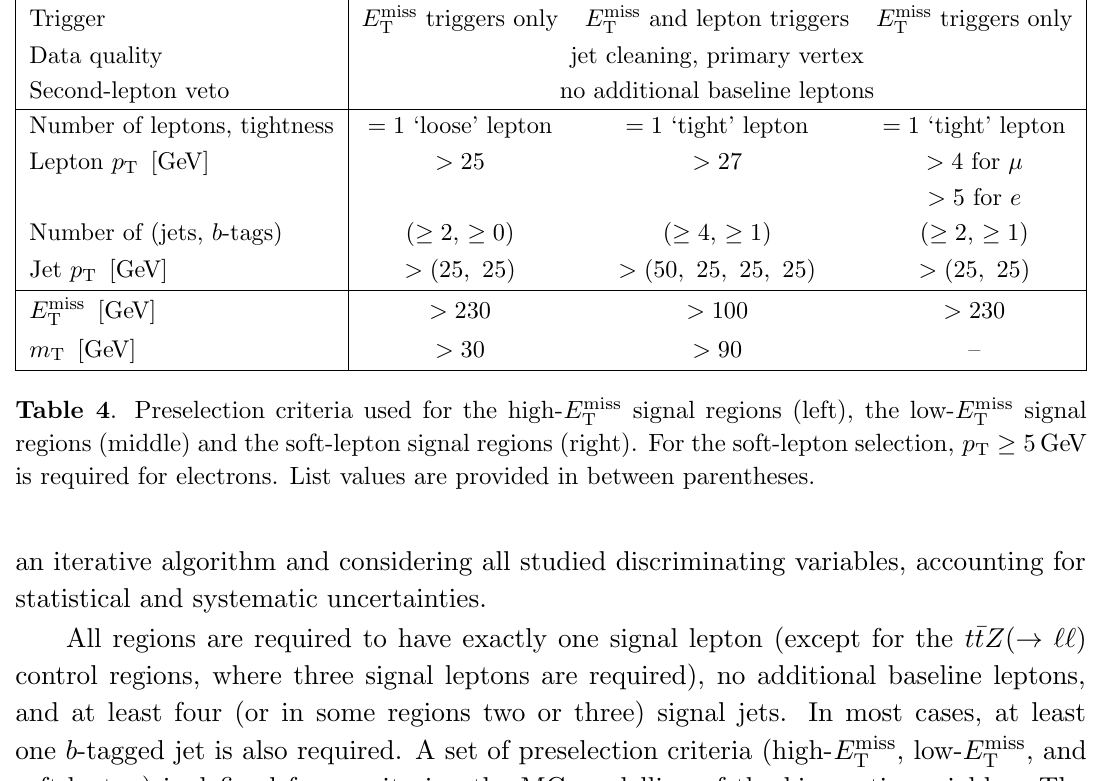
signal regions (left), the low- E miss T